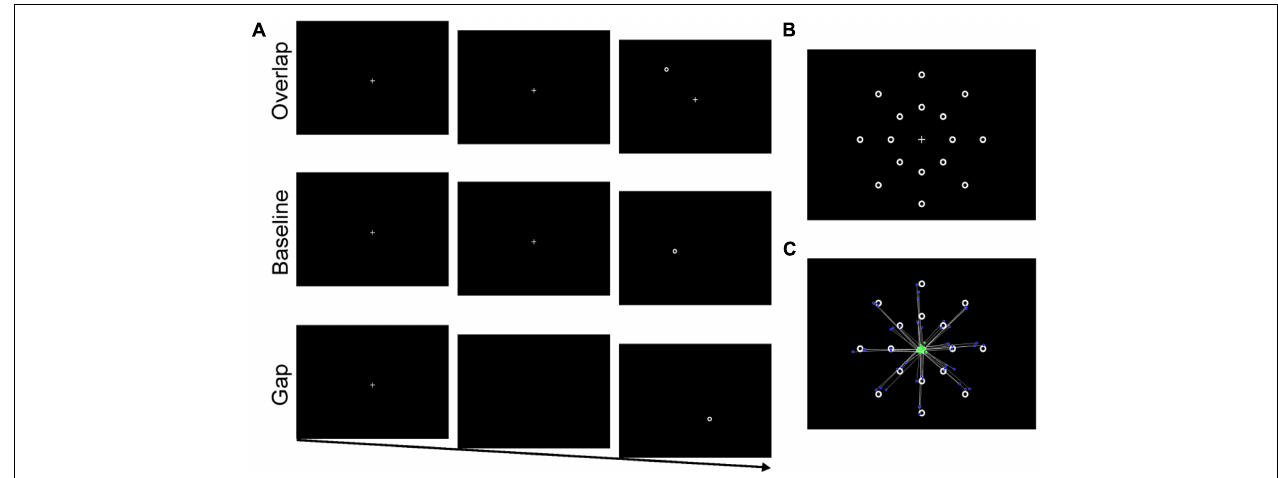
FIGURE 1 | (A) Stimulus sequence for overlap, baseline, and gap conditions. (B) Stimulus array with 16 possible target locations (only one target was present for each trial). (C) An example of saccades from one participant (one block) included in the latency analysis. Green dots represent individual saccade start location and blue dots represent saccadic